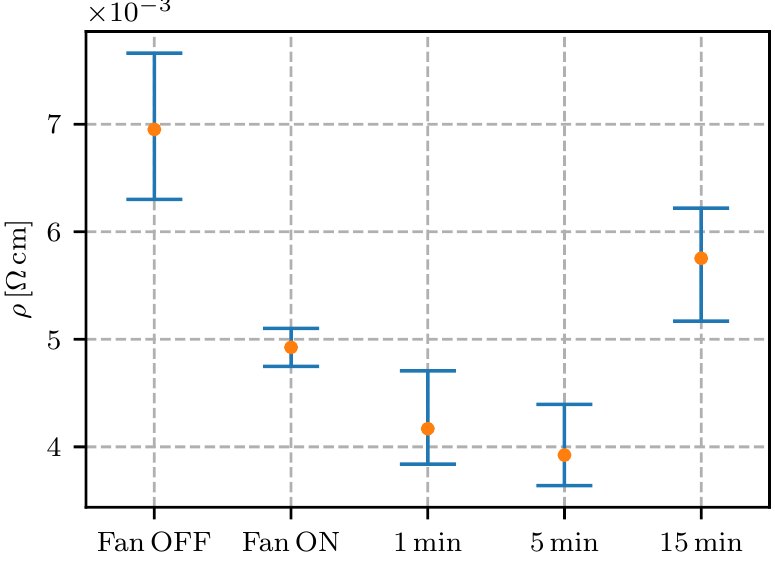
Figure 17. The effect of active cooling during the printing and melting phase after the printing